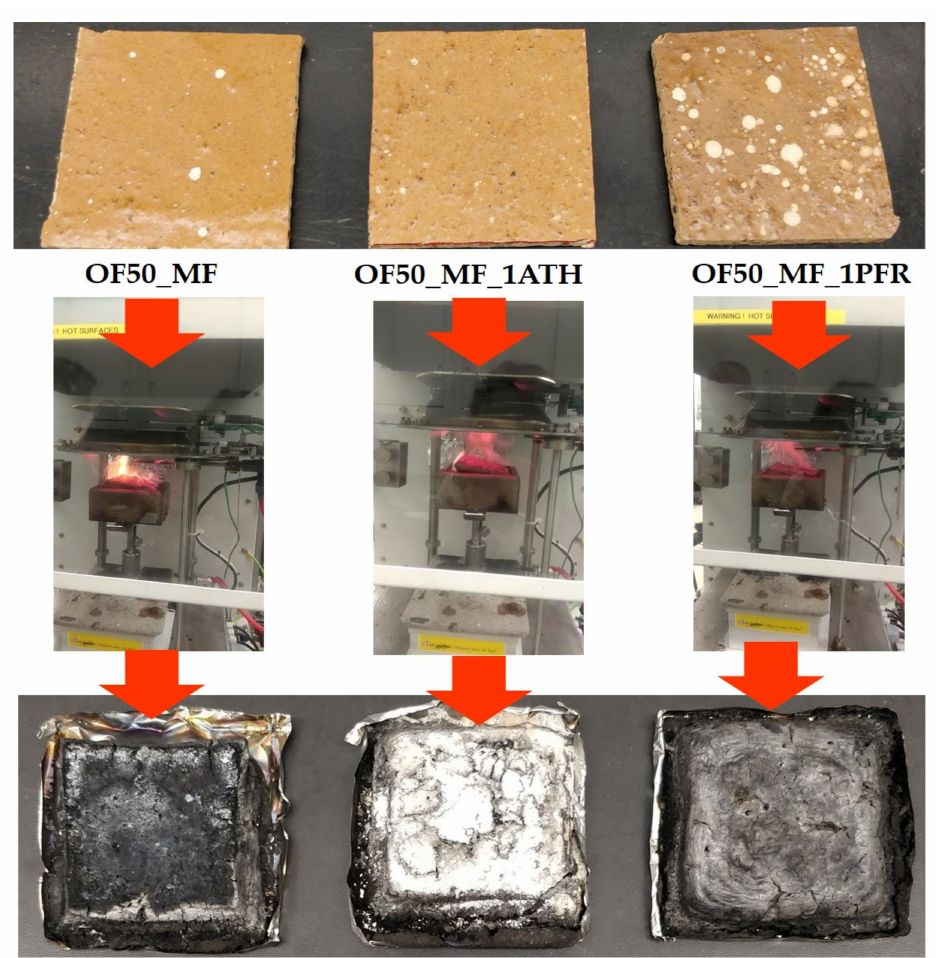
Figure 4. Samples before (top), during (about 300 s from test start) (center), and after the cone calorimeter test